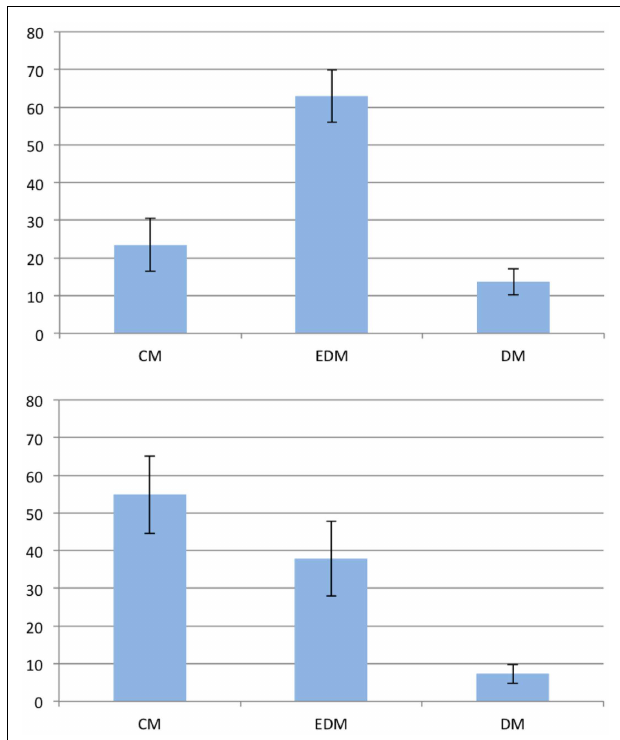
FIGURE 8 | Preferences of the 45˚ problems for the spatial group (top) and the visual group (bottom). The vertical axis represents the frequency of the given answer. Error bars show the standard error of the mean. EDM, equal-distance model; CM, cardinal model; DM, distorted models.